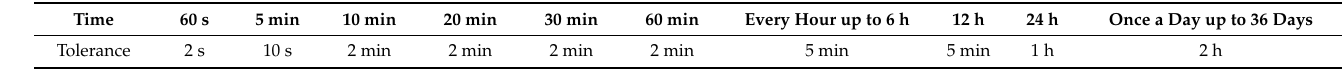
Table 3. Timing and tolerance of capillary water absorption quality tests.